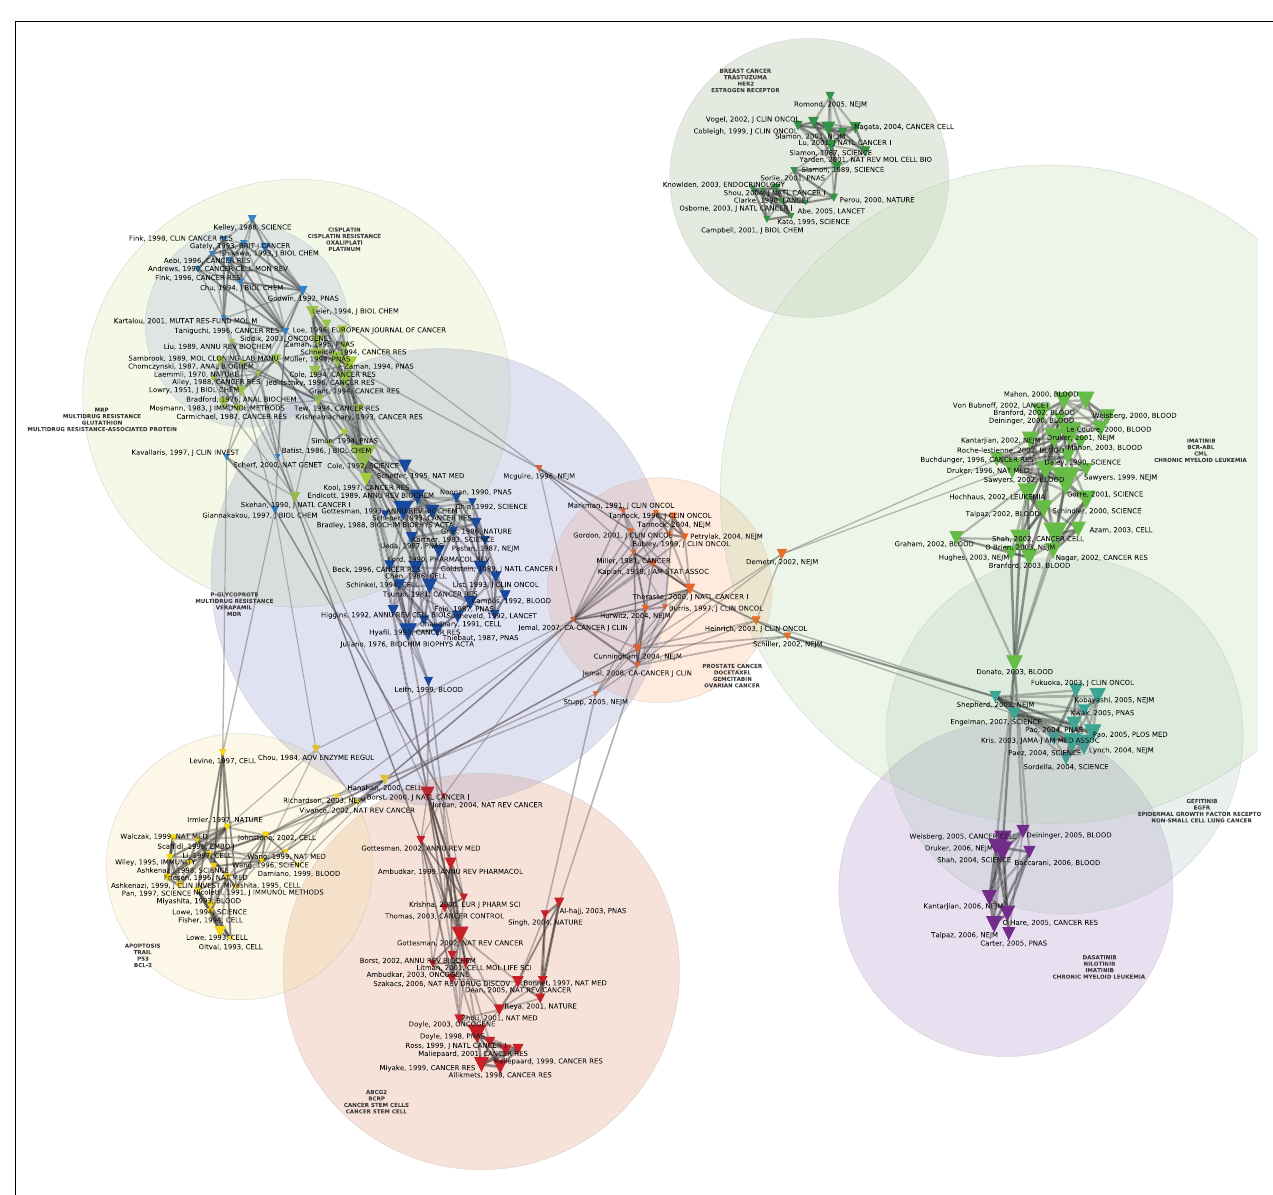
FIGURE 2 | Co Co-citation map of the 200 most-cited references in articles published from 1995 to 2010 in the domain of anti-neoplastic drug resistance. See the legend of Figure 1 for explanations.